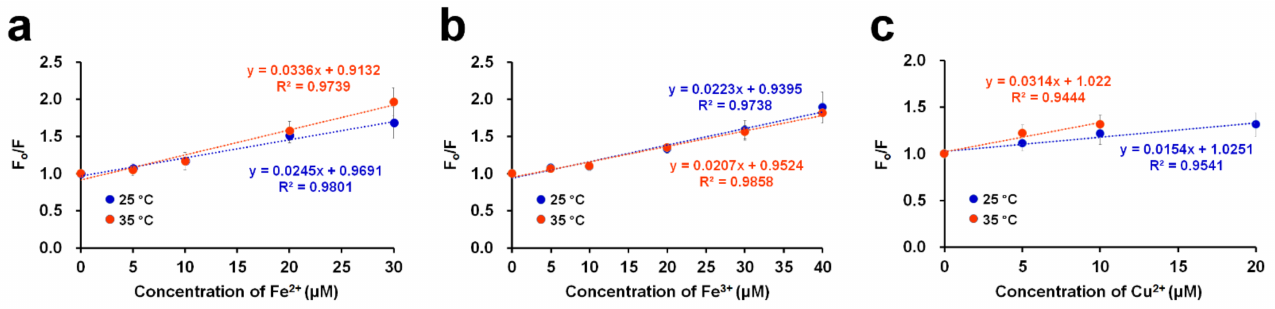
Figure 4. Stern–Volmer plots of the DendFP quenching system by ( a ) Fe 2+ , ( b ) Fe 3+ , and ( c ) Cu 2+ at 2 different temperatures: 25 and 35 ◦